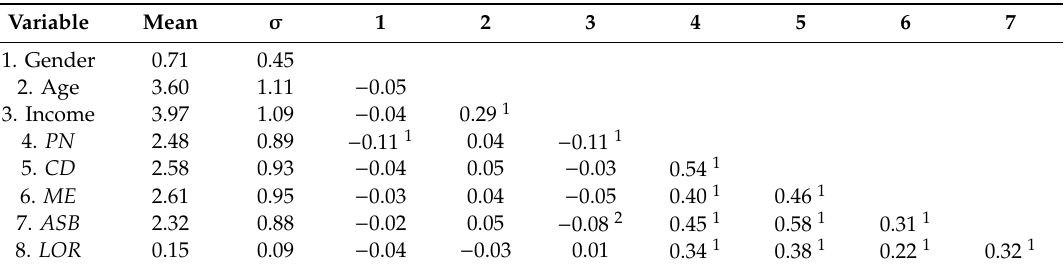
Table 4. Summary statistics of the variables and correlation matrix.